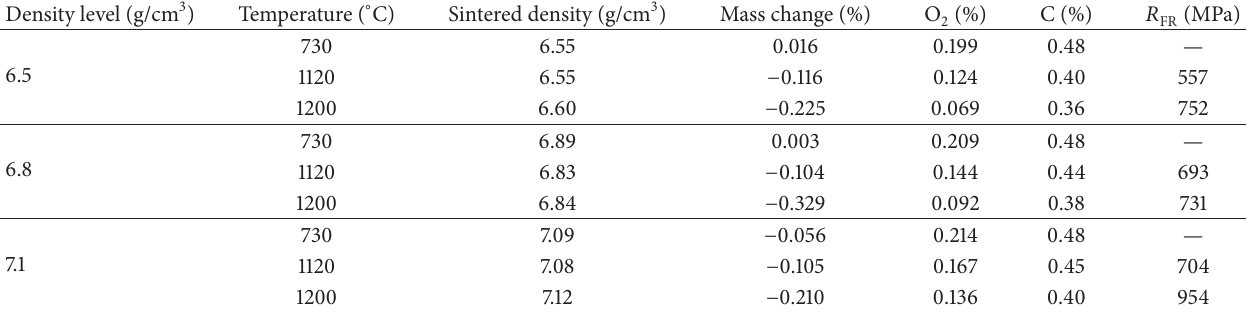
Table 3: The mass change, oxygen and carbon contents, and fracture strength of the AstCrM + 0.5% C material heated to 730, 1120, and 1200 ∘ C and cooled at 50 ∘ C/min in relation to density. Density level (g/cm 3